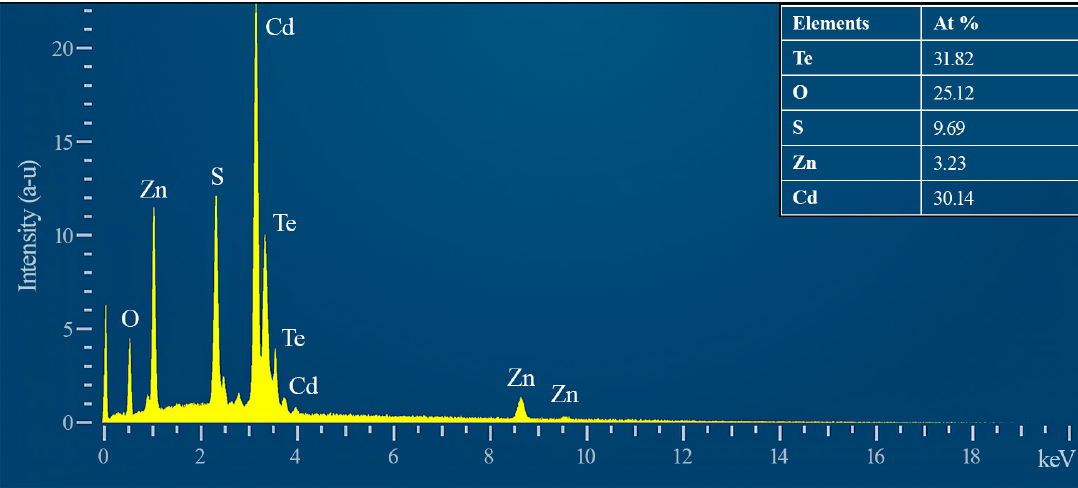
Figure 4. EDX spectrum and component composition of the CdxTeyOz/CdS/ZnO surface.